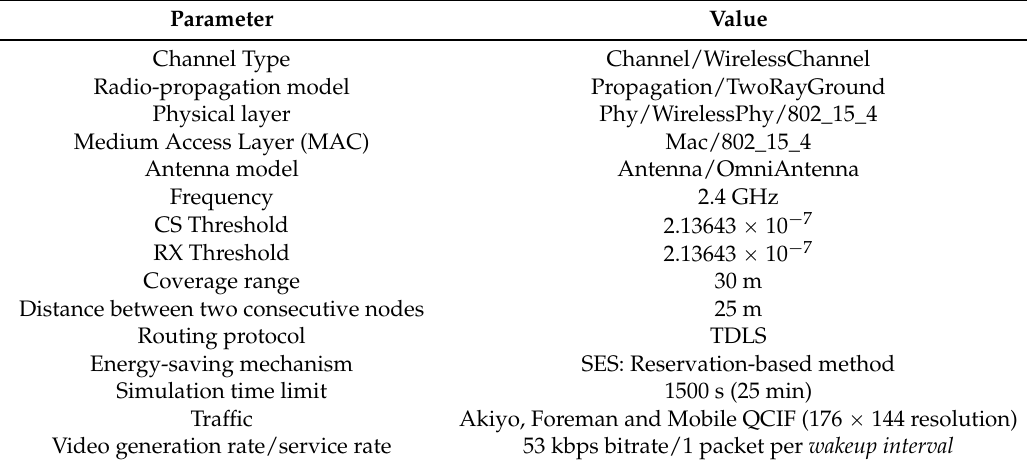
Table 6. Simulation parameters.